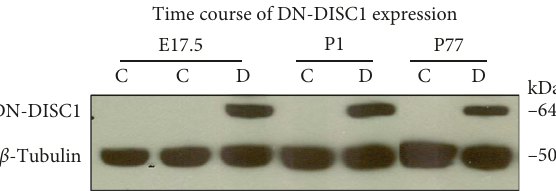
Figure 1: Time course of DN-DISC1 expression in the mouse brain across neurodevelopment. The mouse forebrain was isolated at embryonic day 17.5 (E17.5), postnatal day 1 (P1), and postnatal day 77 (P77) in control (C) and DN-DISC1 (D) mice. Tissue samples were